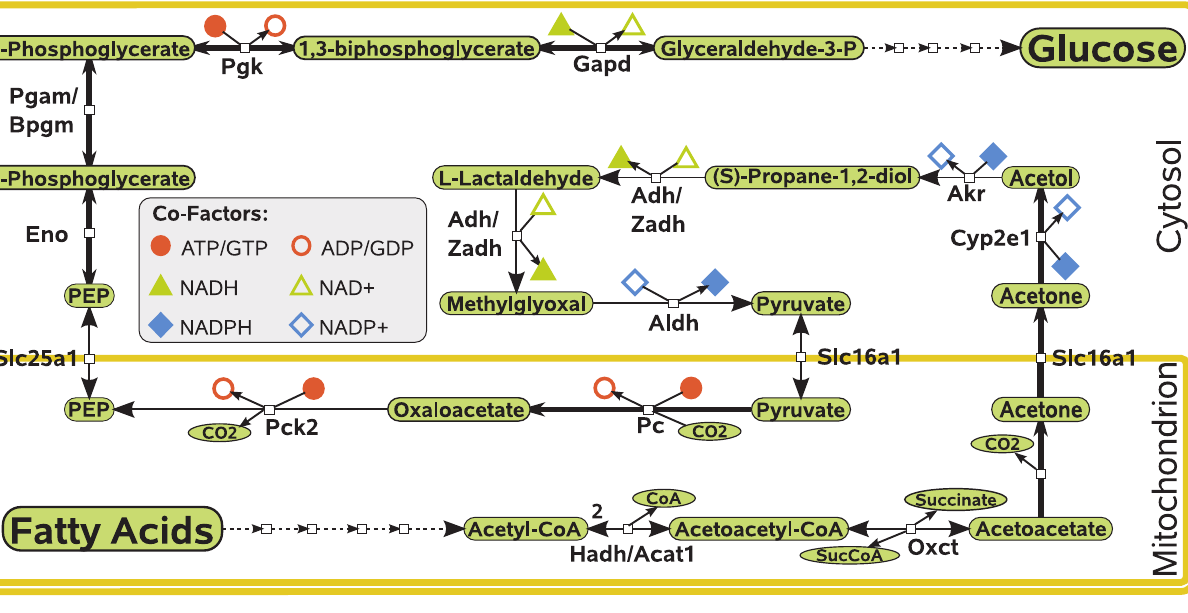
Figure 3. Pathway for the conversion of fatty acids into glucose. Essential reactions of the pathway are drawn with bold arrows. The presented pathway corresponds to the energetically most efficient pathway for the conversion of fatty acids into glucose (pathway 7 in Text S1). A similarly efficient pathway, pathway 14, uses almost the same route but converts acetol directly into methylglyoxal by reduction with NADPH. A list of abbreviations can be found in Table S1.